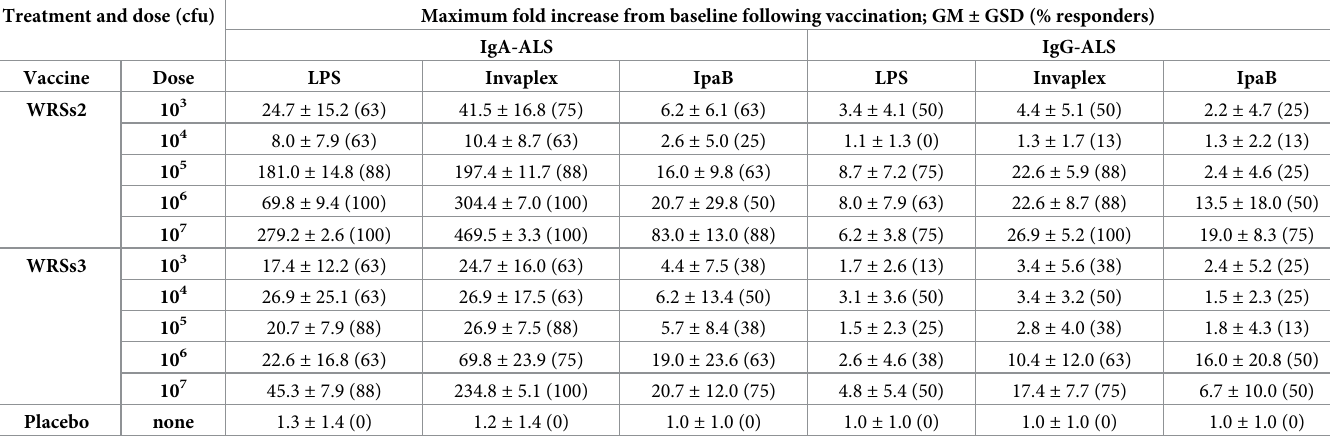
Table 1. Magnitude of the ALS response in WRSs2 and WRSs3 vaccinees: IgA and IgG to LPS, IVP and IpaB. Treatment and dose (cfu)